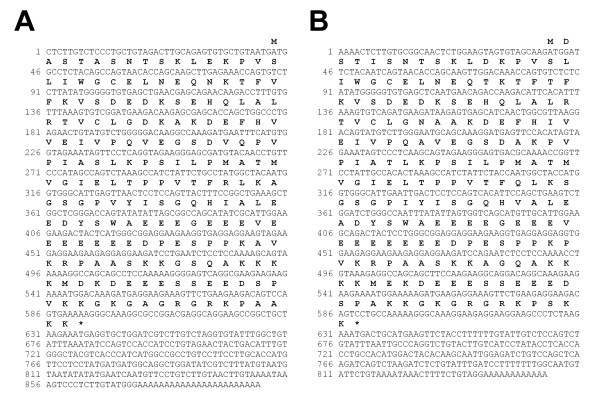
Coding nucleotide sequences of B. marinus and R. catesbeiana nucleoplasmin. The nucleotide sequences determined in this study and translated protein sequences of nucleoplasmin cDNAs from A) B. marinus [GenBank: DQ340657] and B) R. catesbeiana [GenBank:DQ340656] are shown.